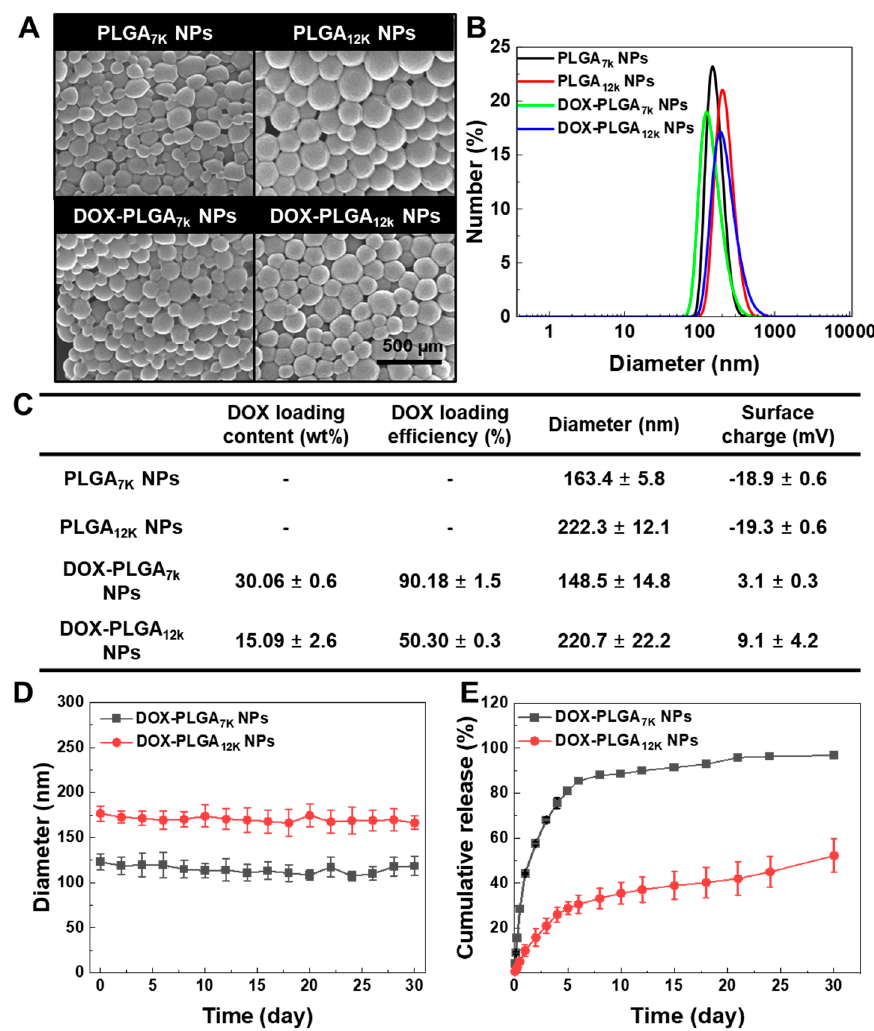
Figure 1. In vitro physicochemical properties of the PLGA nanoparticles (NPs). The morphologies ( A ) and size distribution ( B ) of the PLGA 5K NPs, PLGA 12K NPs, DOX-PLGA 7K NPs, and DOX-PLGA 12K NPs were observed using FE-SEM and a zeta-sizer, respectively. The size, surface charge, DOX loading content, and DOX loading e ffi ciency were summarized in the characteristics table ( C ). ( D ) The size stability of the DOX-PLGA 7K NPs and DOX-PLGA 12K NPs for 30 days. ( E ) In vitro DOX release of the DOX-PLGA 7K NPs and DOX-PLGA 12K NPs. When DOX was loaded into the PLGA NPs, the